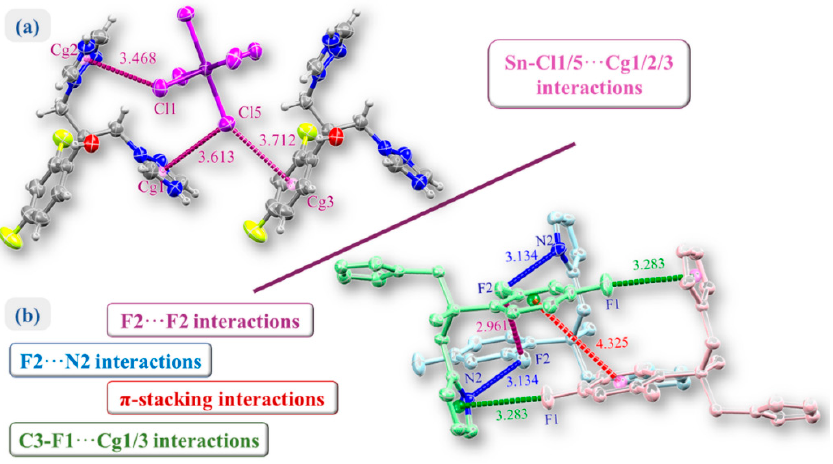
Figure 2. Hydrogen bond interactions in (H2Fluconazole).SnCl 6 .2H 2 O.